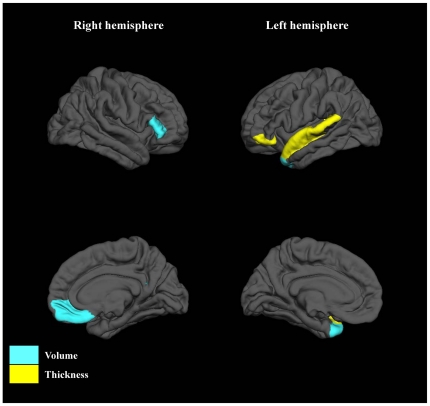
Discriminative pattern for female subjects.Selected regions were differentially colored when volume (blue) or thickness (yellow) of those regions were entered into the model.